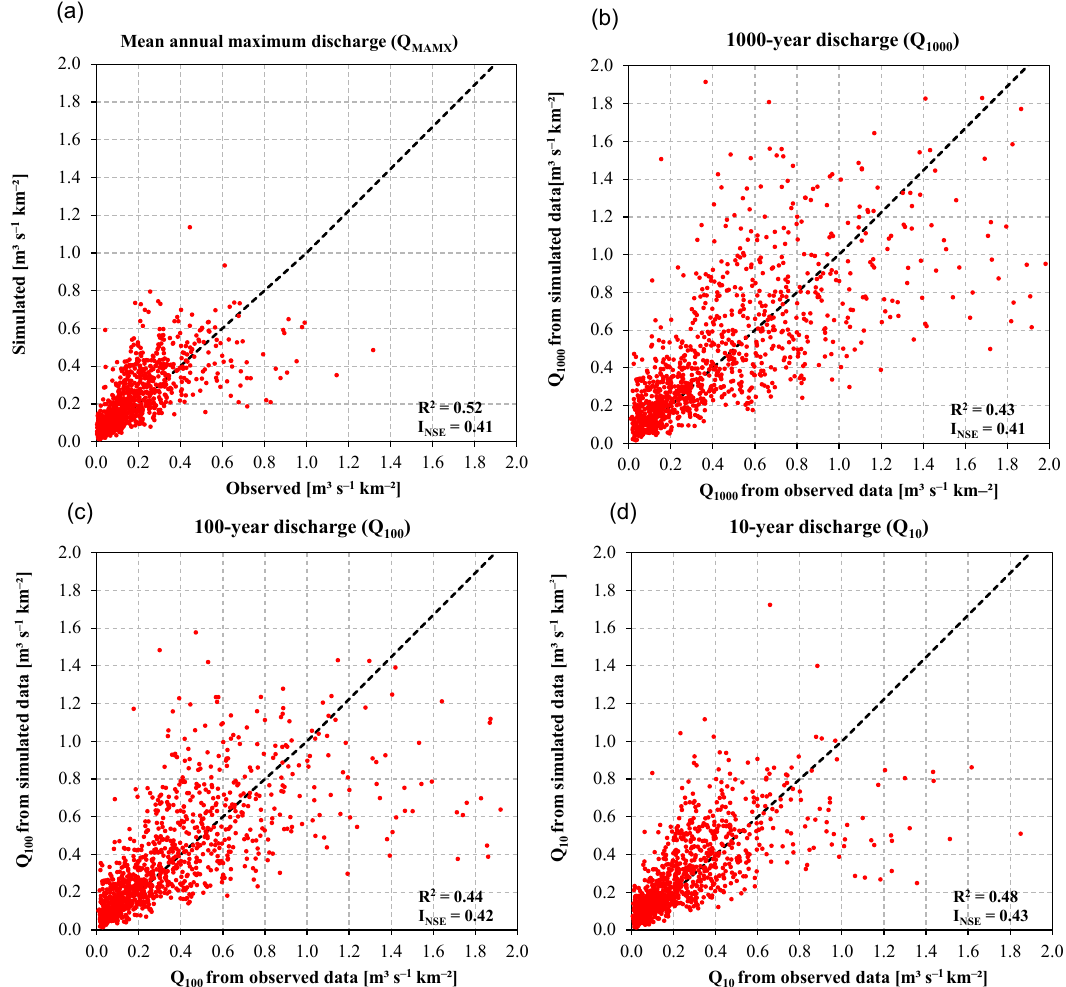
Figure 6. The same as Fig. 5, but for specific discharge, i.e. divided by catchment